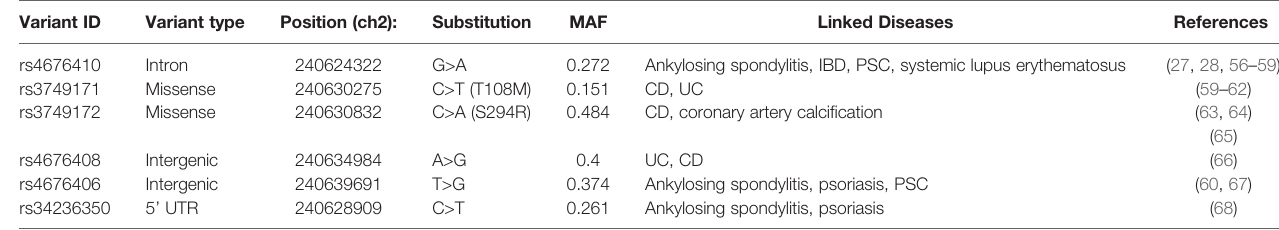
TABLE 2 | Risk variants of GPR35 associated with